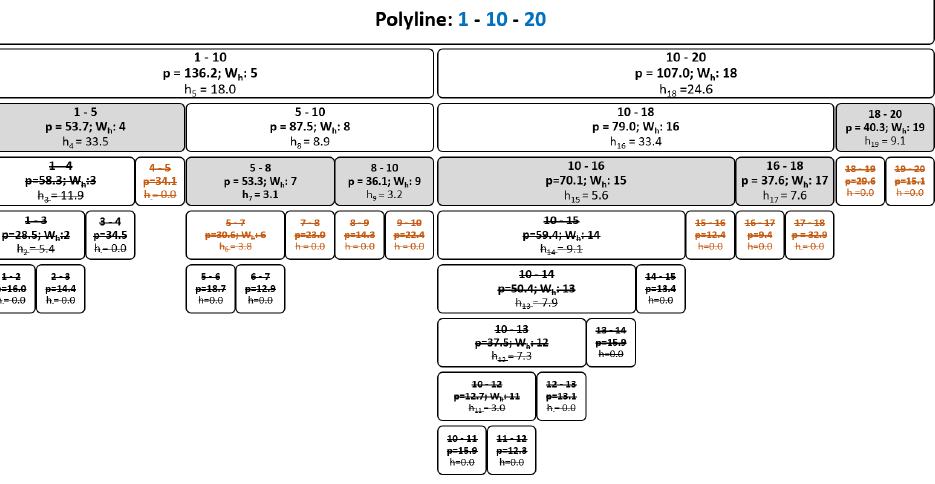
Fig. 5. Structure of the binary tree of ordered polyline L u after simplification from scale 1:10,000 to scale 1:50,000 (in brown − triangles that do not meet the fr d condition; crossed out − triangles rejected as a result of simplification; shaded blocks − the polyline remaining after